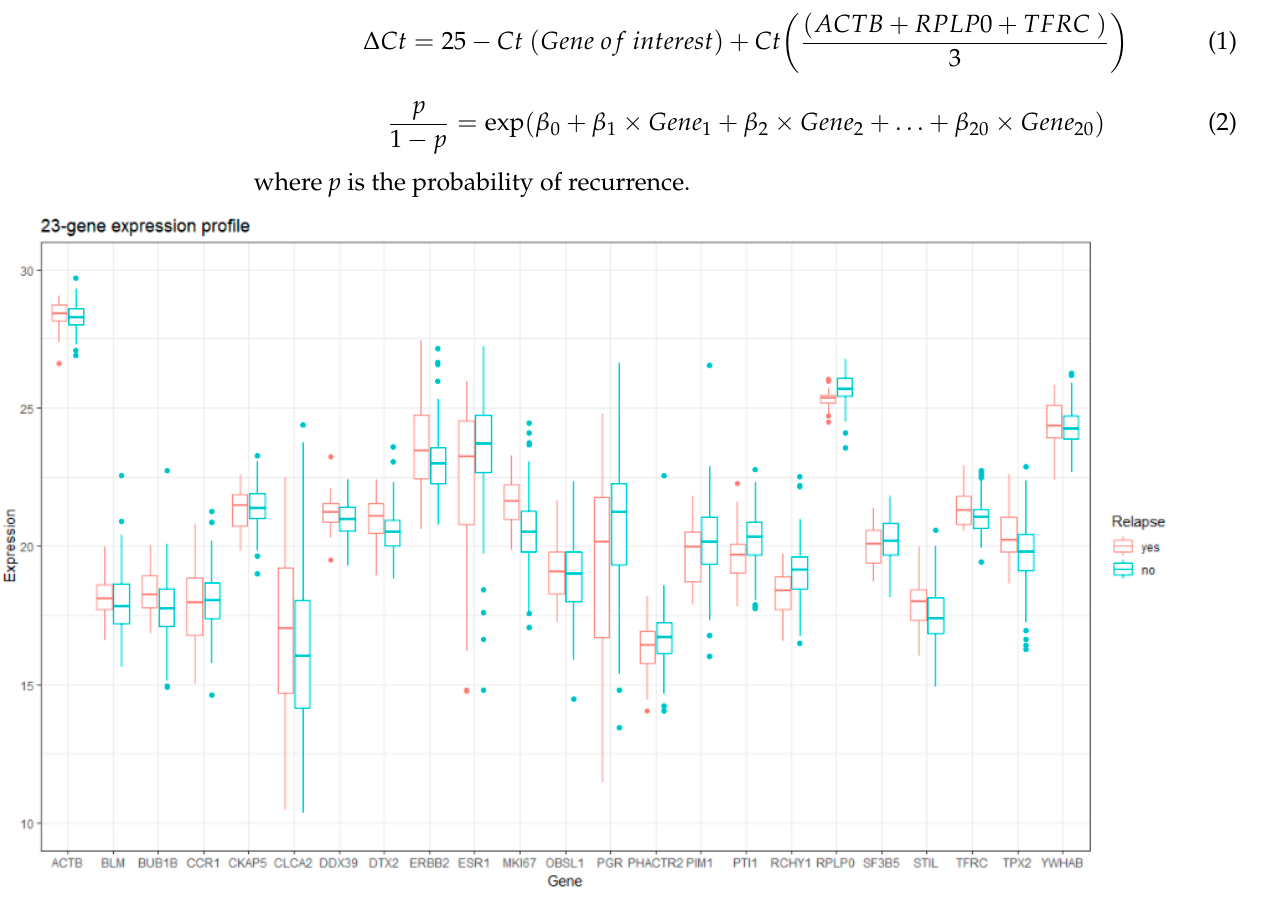
Figure 2. The boxplot for the visualization of 23-gene expression divided by recurrence status. Red: recurrence; blue: no recurrence; x-axis: 23 genes; y-axis: gene expression.